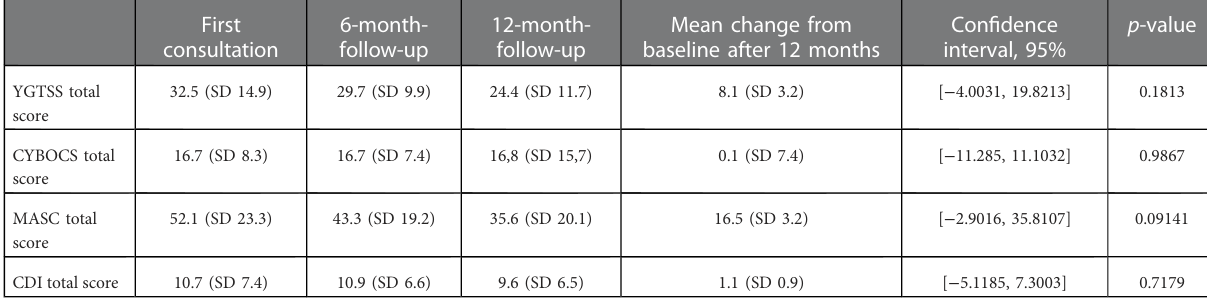
TABLE 2 Yale global Tic severity rating scale (YGTSS), children ’ s Yale-brown obsessive-compulsive scale for children (CY-BOCS), multidimensional anxiety scale for children (MASC), child depression inventory (CDI) outcome in patients affected by FTLBs. First